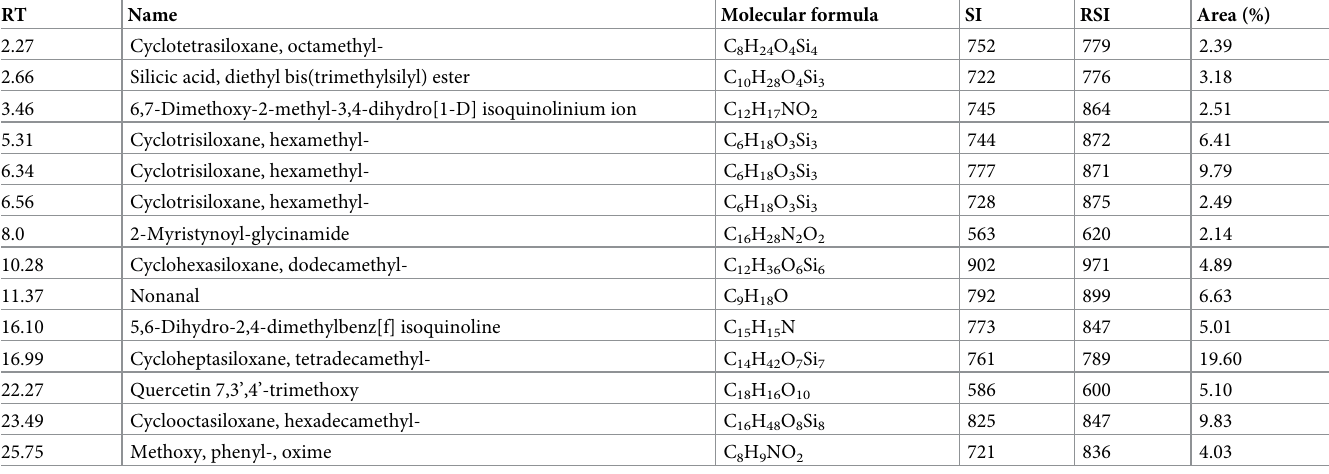
Table 1. SPME-GC-MS analysis of supernatant of Flavobacterium sp . SI, direct matching factor, RSI; reverse search matching factor.